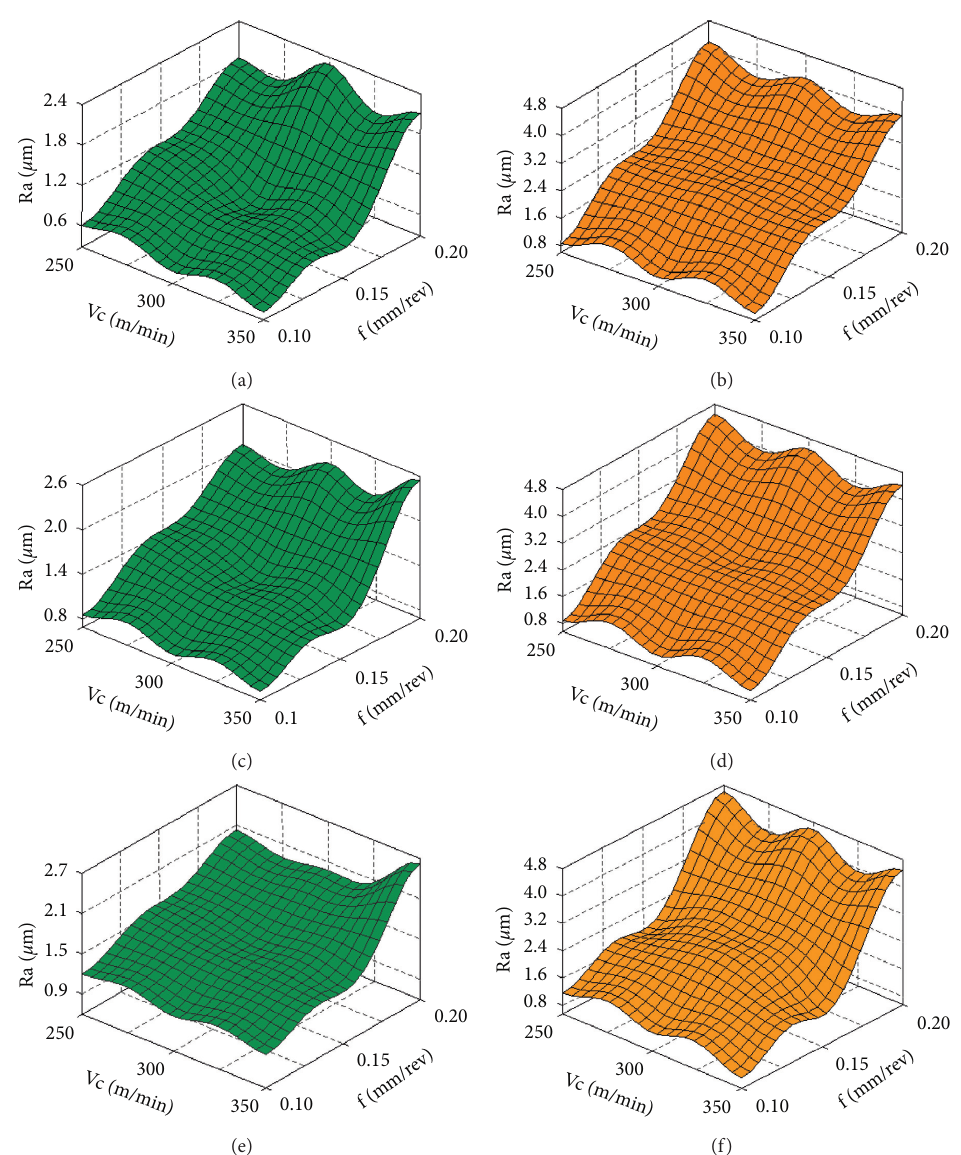
Figure 3: Effects of machining parameters on Ra. (a) Uncoated insert/a � 1mm; (b) TiB2 coated insert/a � 1mm; (c) uncoated insert/ a � 1.5mm; (d) TiB2 coated insert/a � 1.5mm; (e) uncoated insert/a � 2 mm; (f) TiB2 coated insert/a �